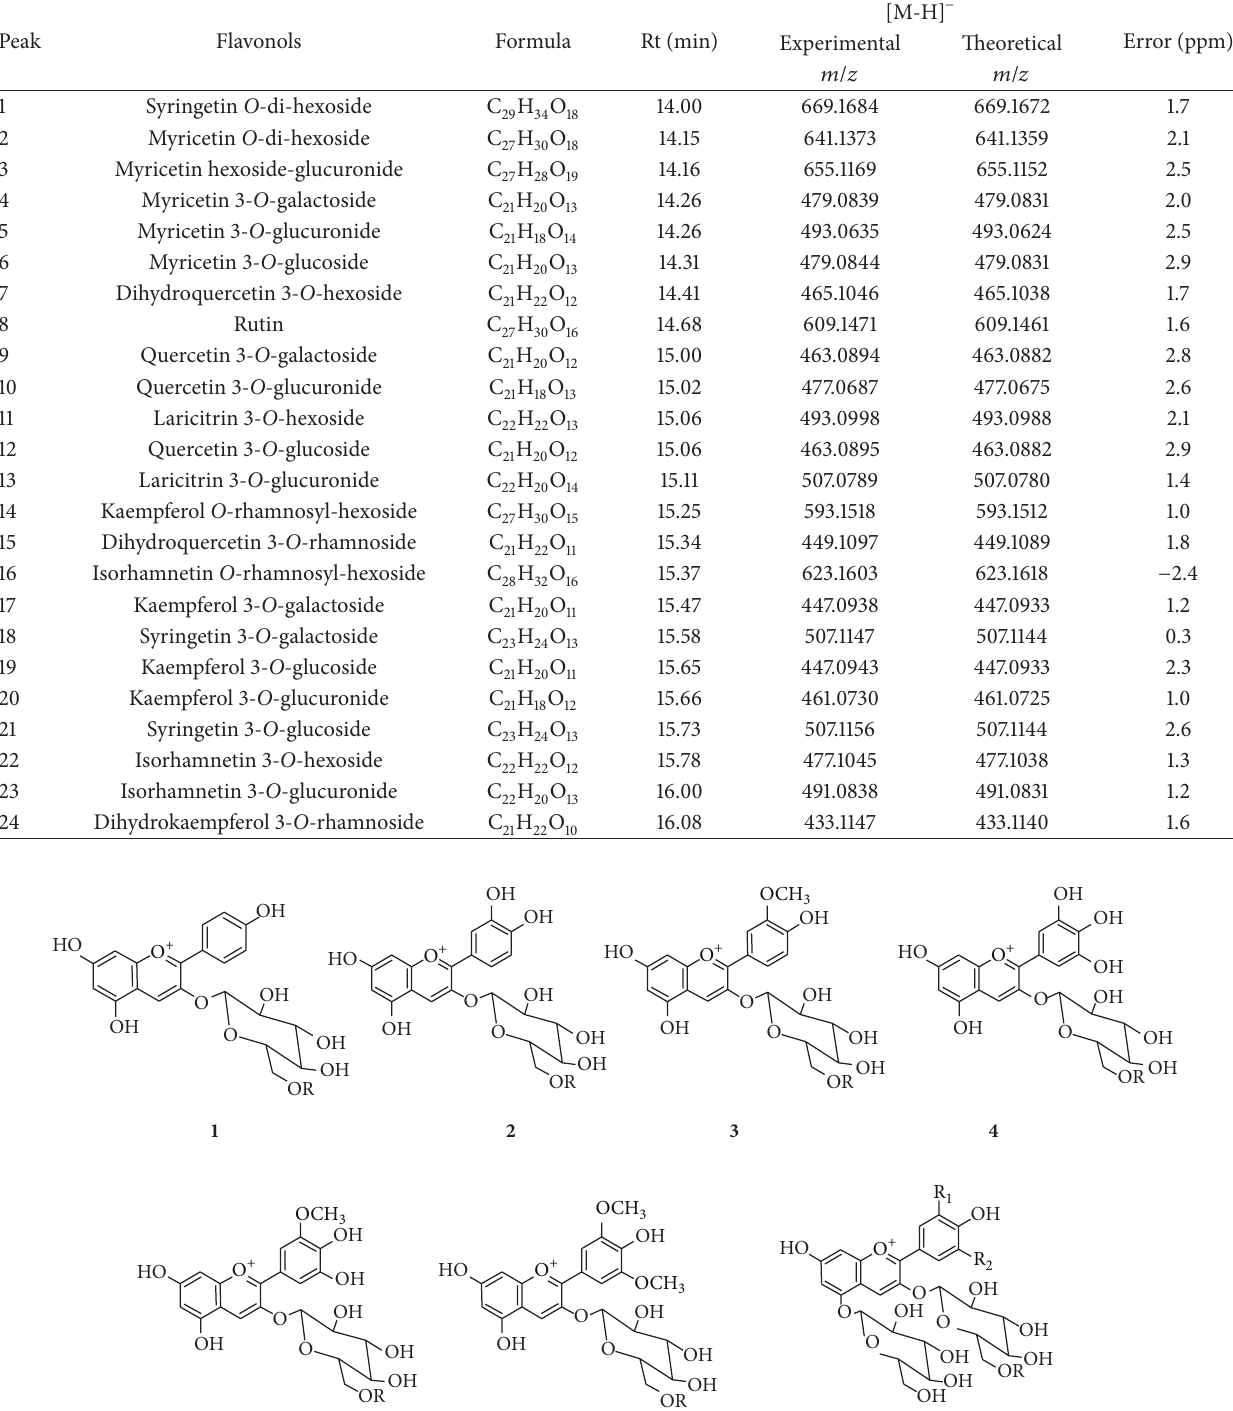
Table 1: Glycoside flavonol [ M-H ] − ions identified in hybrid grapes Seibel 19881 and Seyve Villard 12-347. Identification scores calculated with respect to the theoretical mass are reported. Numbers correspond to the peaks of chromatogram in Figure 2 (adapted from de Rosso et al., 2014 [10]).